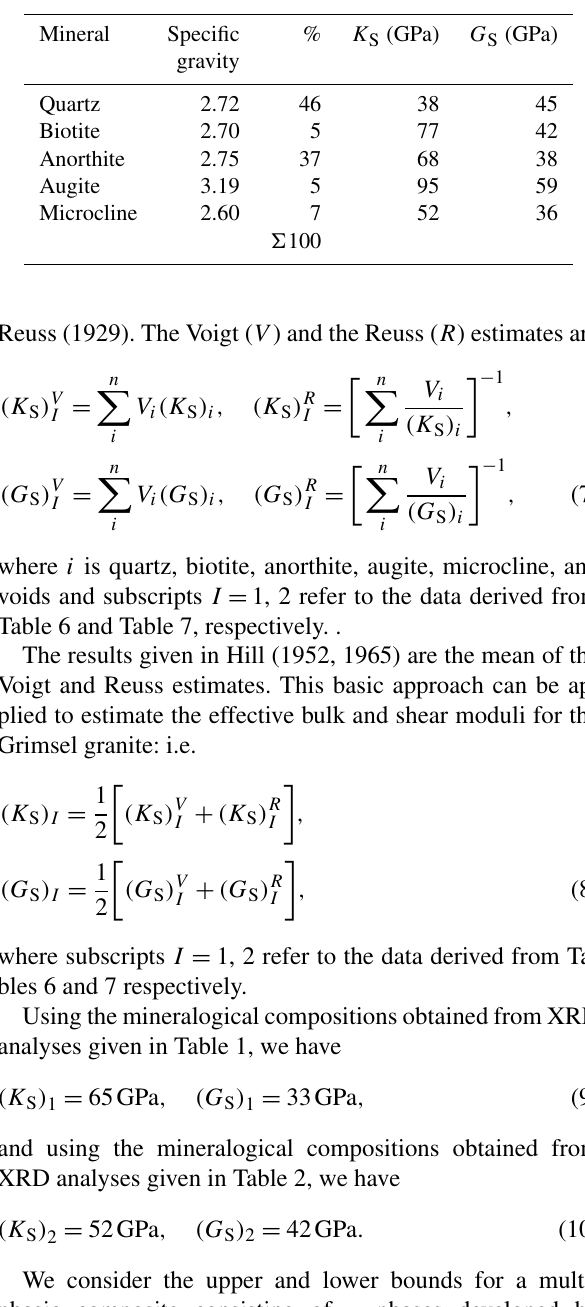
Table 7. Mineralogical fractions of the Grimsel granite (data ob- tained by the Earth Sciences Laboratory, University of